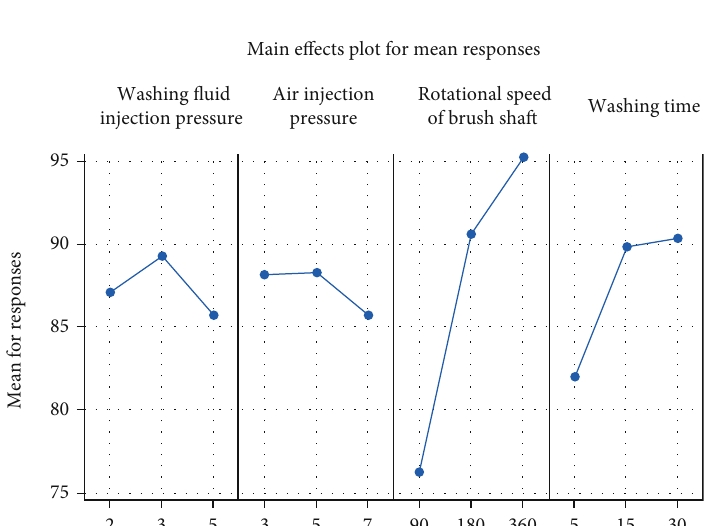
Figure 16: Mean S-N ratio graph.